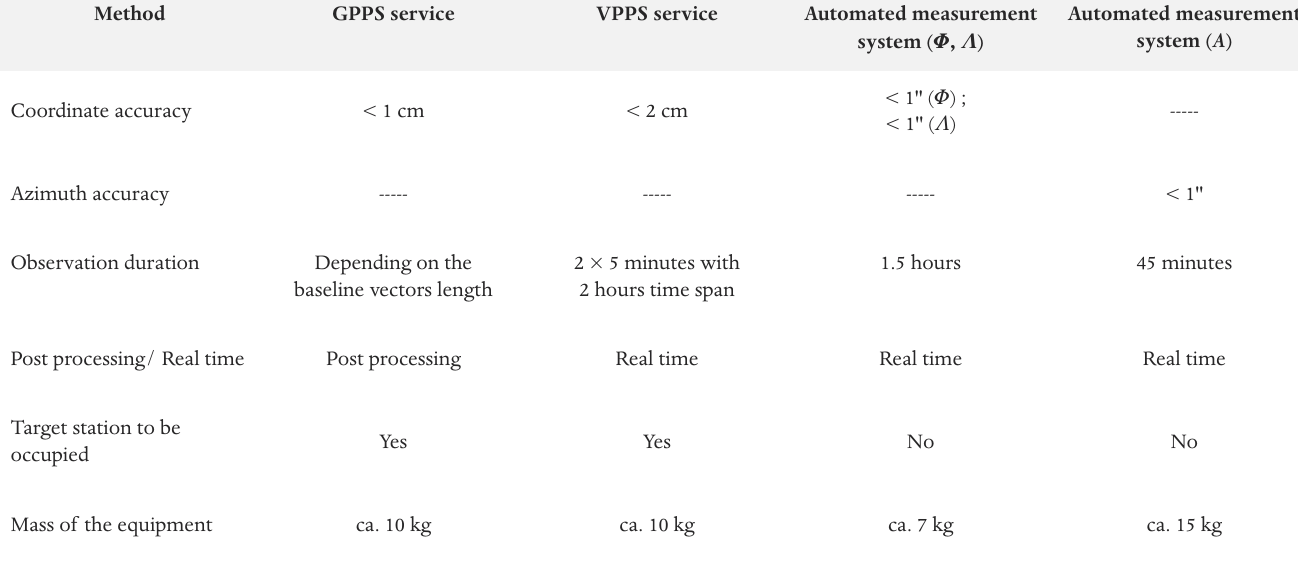
Table 9. Main characteristics of the used azimuth determination